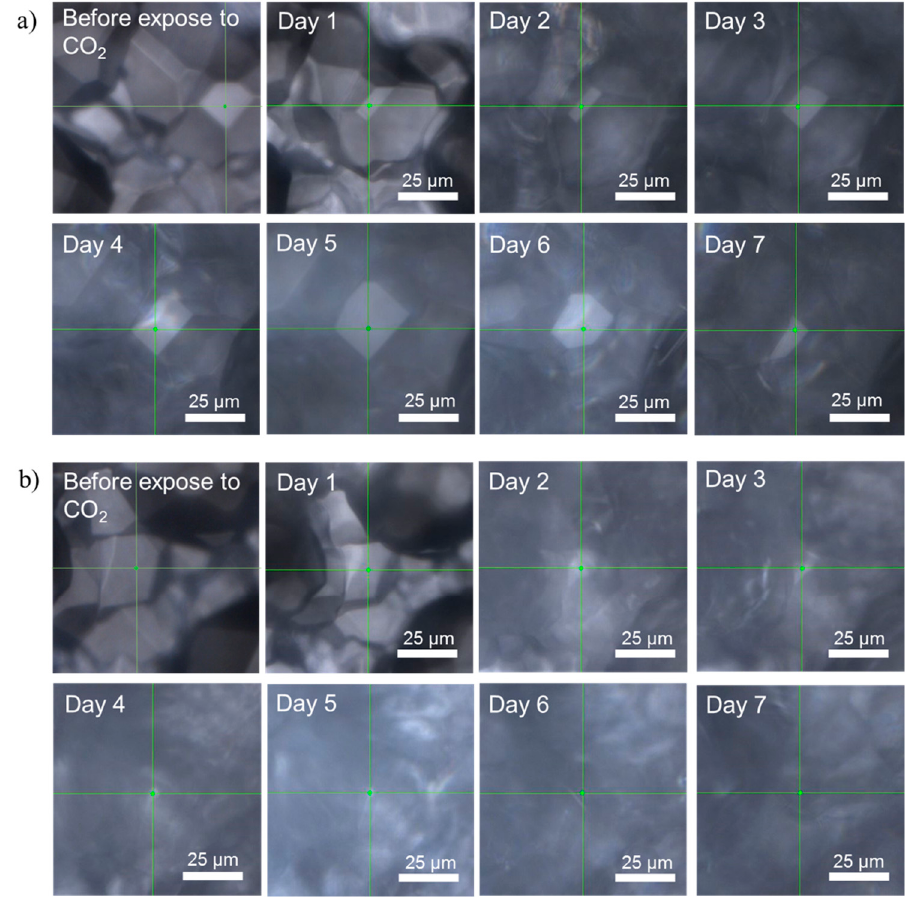
Figure 9. Changes in surface morphology on two CH 4 hydrate crystals (shown in ( a ) and ( b ), separately) after the shift of gas phase to CO 2 gas at experiment conditions of p = 3.2 MPa and T = 274 K. The CH 4 hydrate crystal in Figure 9a was found to grow in the first few days followed by a shrinking on the last day. However, the crystal in Figure 9b experienced a continuous dwindling and disappeared on Day 7. The green point with crossed lines was the exact measuring spot site on the hydrate crystal.